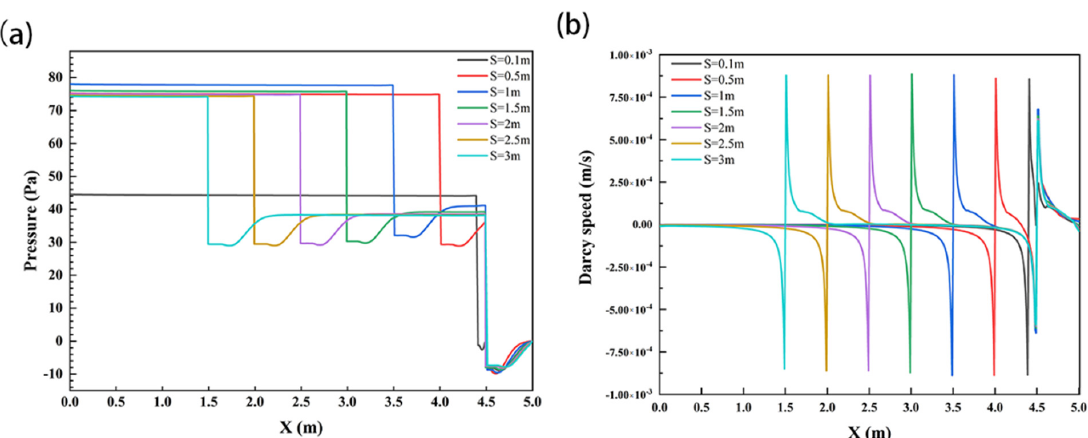
Figure 8. SWI pressure distribution diagram ( a ) and velocity distribution diagram ( b ) under the influence of structural spacing change. Channel flow is left to right.